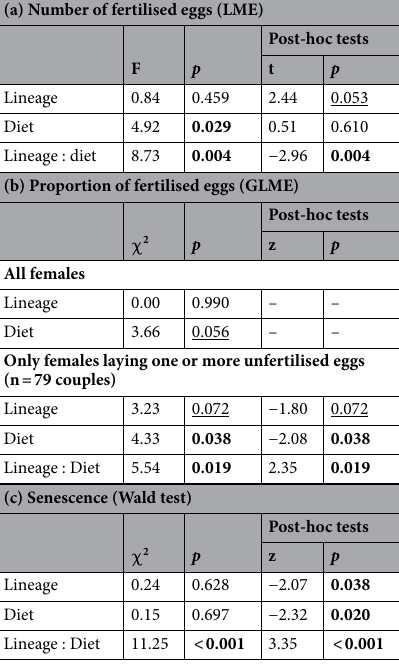
Table 1. Results of statistical analysis of male diet (foreign/original) and lineage (bat/human) effects on fertilisation success after single mating with tester female (n = 92 couples). Values in bold represent significant effects and nearly significant effects are